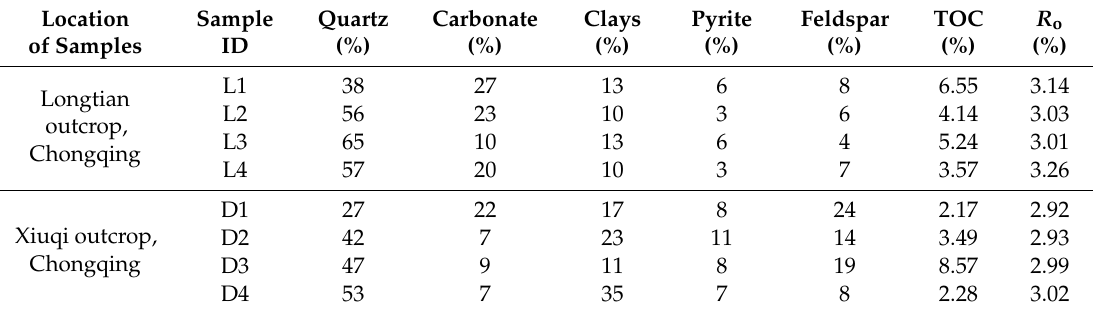
Table 1. Total organic carbon (TOC), R o and XRD mineral composition characteristics of the shale samples. Location of